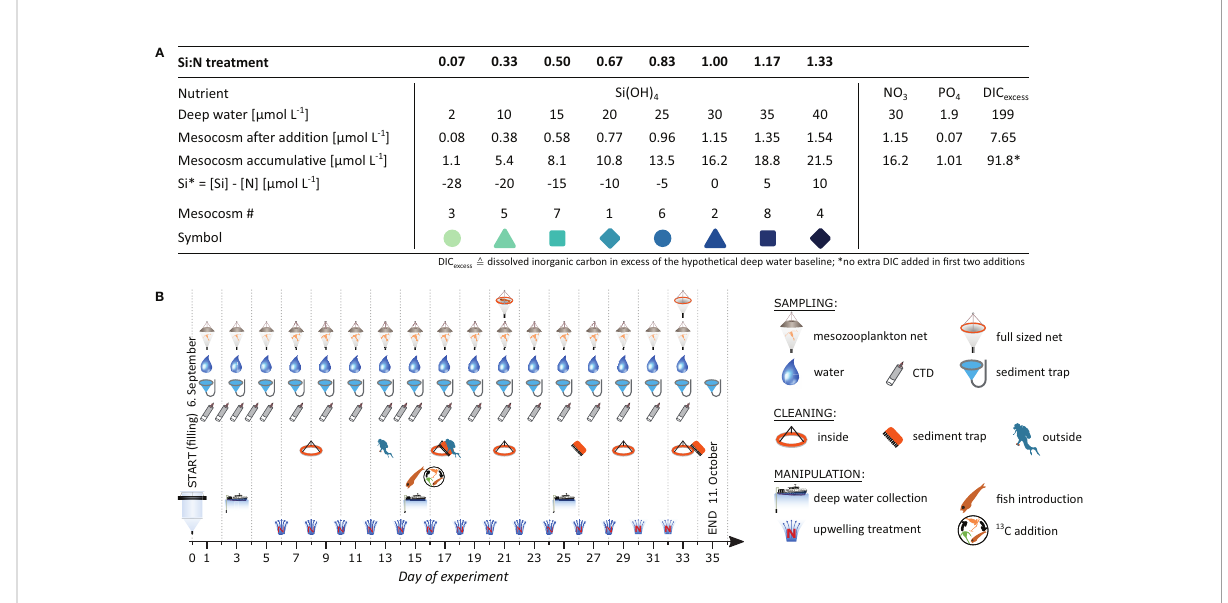
FIGURE 2 Experimental design to simulate arti fi cial upwelling. (A) Nutrient regime with a gradient in silicate and constant levels of the other macro- nutrients (at Red fi eld). Each of the 14 additions exchanged 4% of the mesocosm (320 L). (B) Experimental